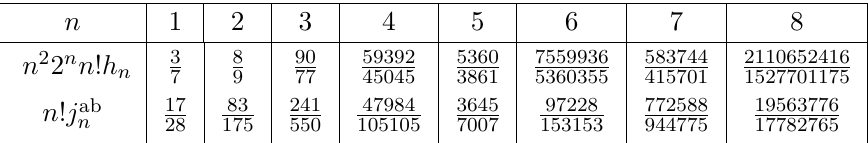
The normalized coefficients of the Taylor series for the function h ( z ) and j ab ( z ) up to n = 8